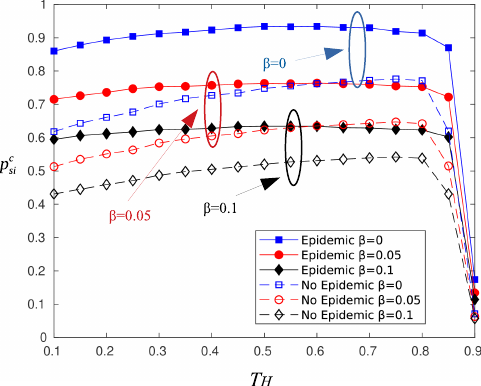
Figure 8. Effect of epidemic mechanism on p c